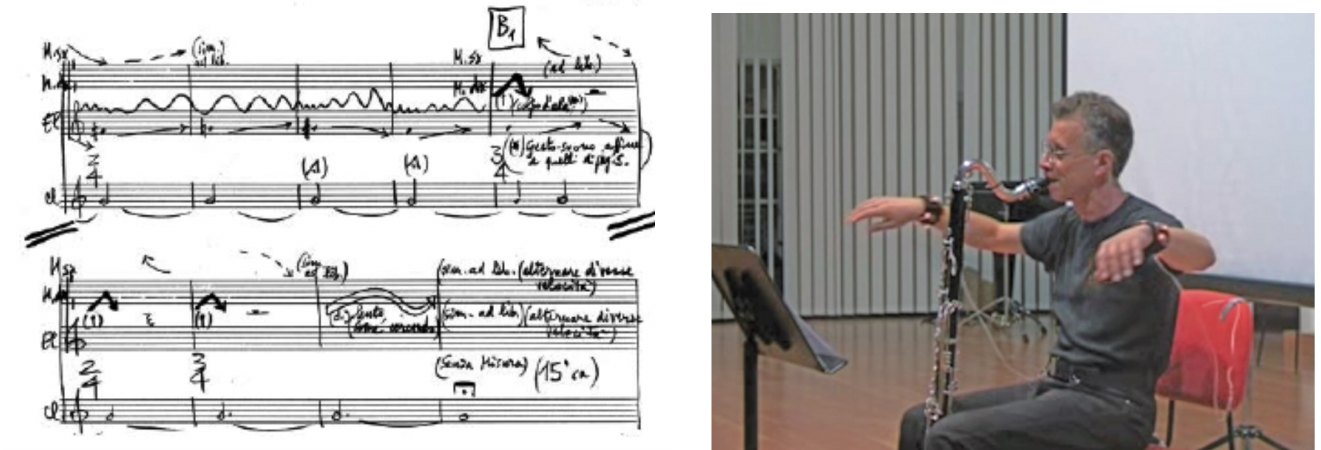
Figure 24. Gestural control of Ogni emozione dell’aria by Claudio Ambrosini: excerpt of the score with right hand movements ( left ); gestural performance by Davide Teodoro ( right ).